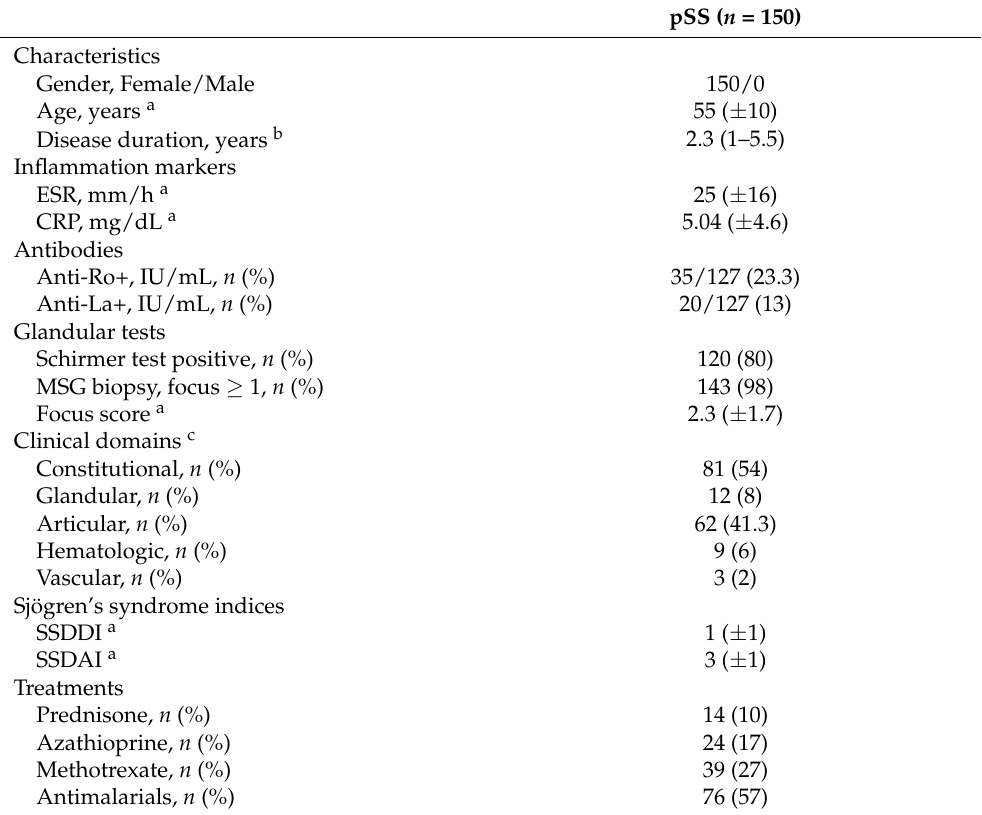
Table 2. Demographic and clinical characteristics of the primary Sjogrën syndrome